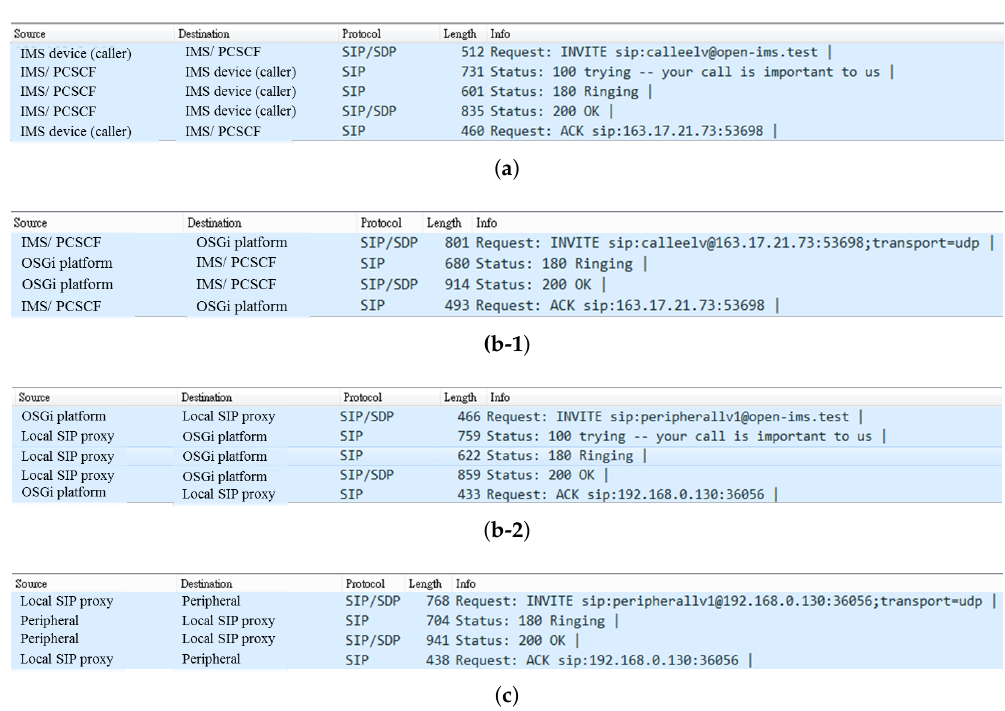
Figure 12. A voice call session procedure: ( a ) a session invitation initiated by a Callee; ( b ) the session invitation accepted by the IMS service proxy platform for session passing between a peripheral device and the IMS service proxy platform; and ( c ) the peripheral device responding to the session passing for exchanges of media resources with the